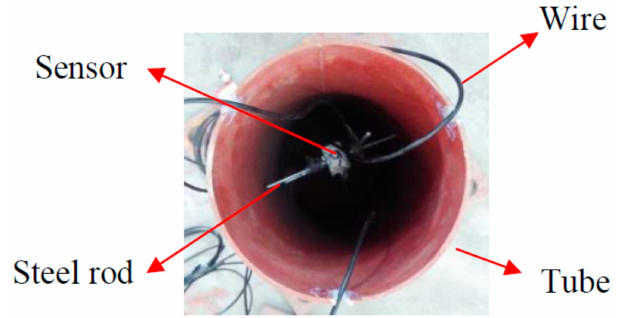
Figure 5. Sensors in a steel tube prior to concrete